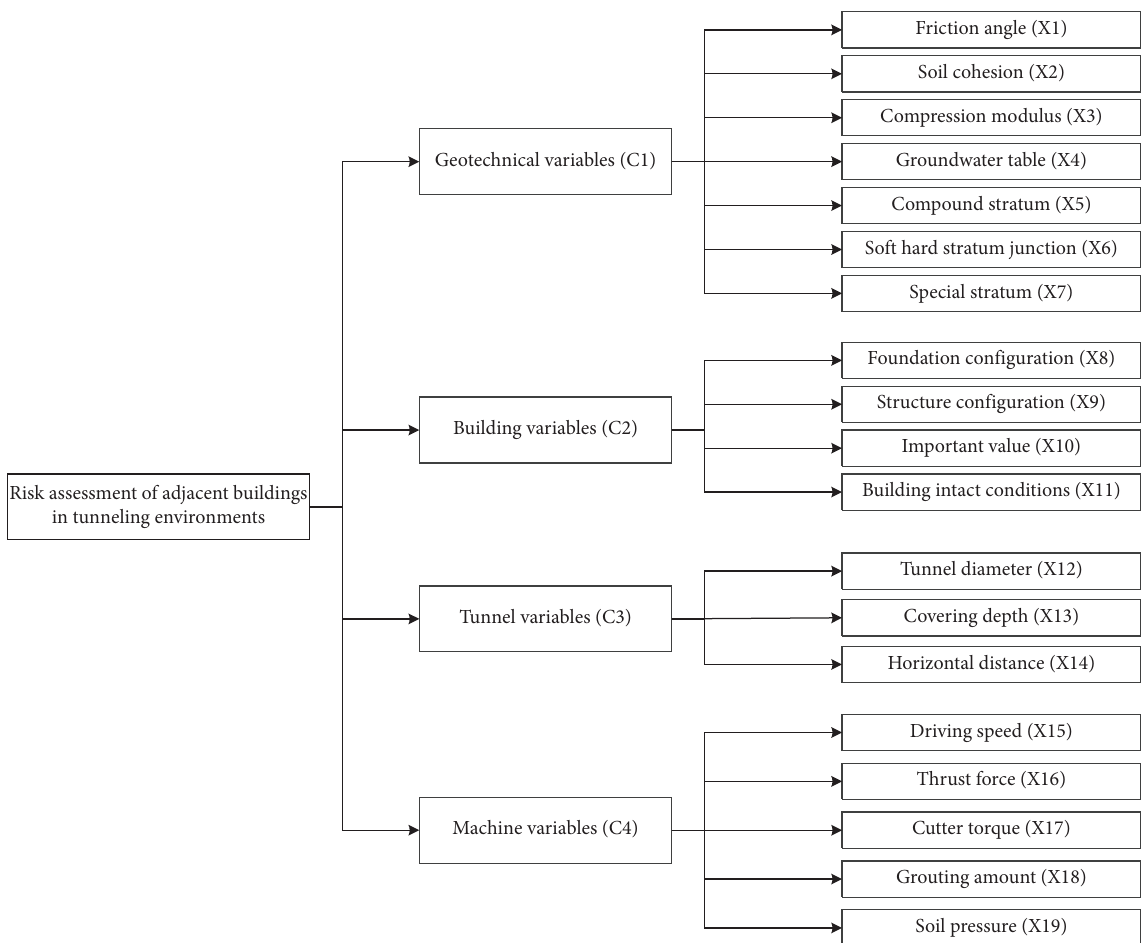
Figure 2: Risk assessment system for adjacent buildings in shield tunneling Table 2: Risk level of infuence variables.